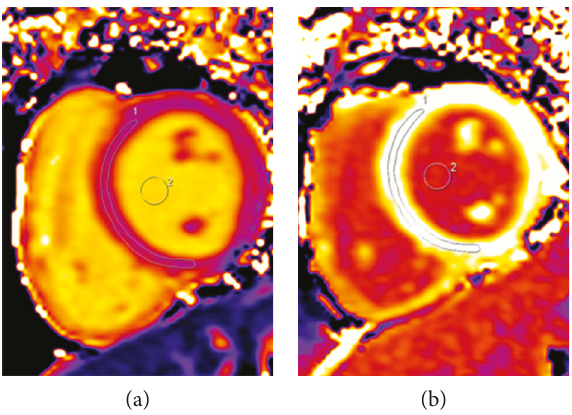
Figure 1: ROIs on native (a) and postcontrast (b) T1